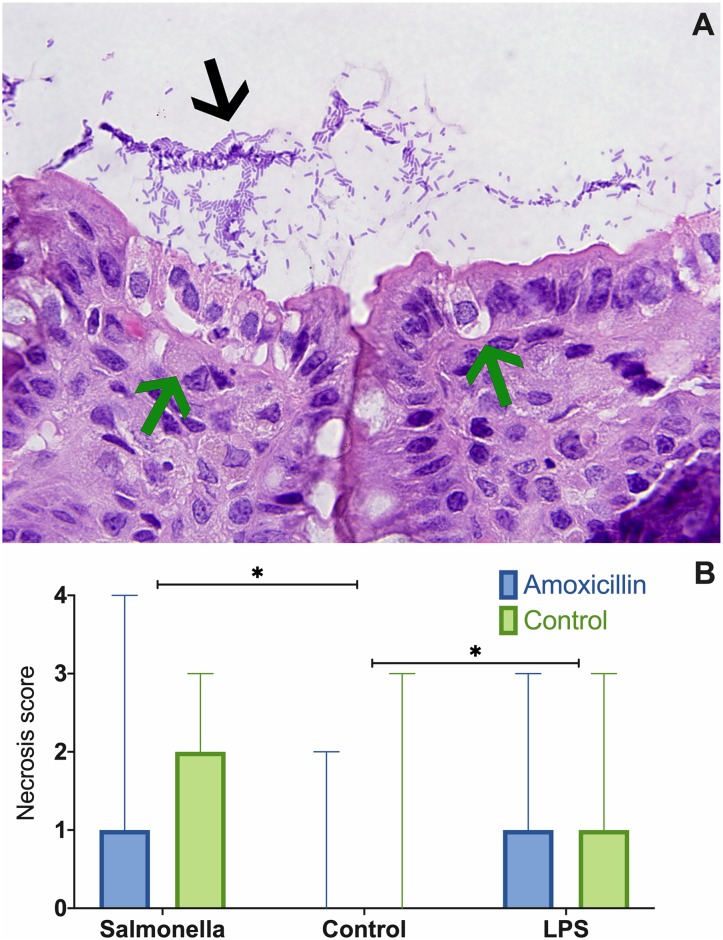
H&E stained section of explant inoculated with Salmonella enterica Typhimurium, from a pig not treated with amoxicillin.Loss of superficial epithelial layer cells (green arrows) and a mat of bacilli (black arrow) is observed (A). Bar chart (median and range) based on necrosis scores from H&E stained explant sections. Stars denotes differences between inoculum groups (P < 0.05, B).